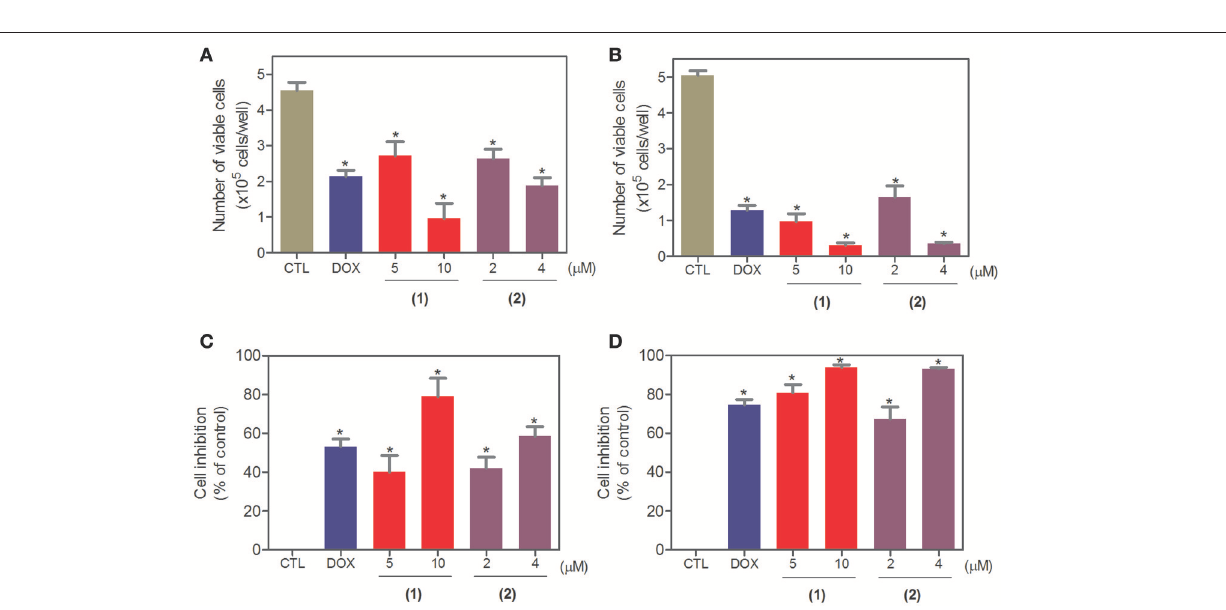
Differences among experimental groups were compared using analysis of variance (ANOVA) followed by the Student– Newman–Keuls test ( P < 0.05). All statistical analyses were performed using GraphPad Prism (Intuitive Software for Science; San Diego, CA,